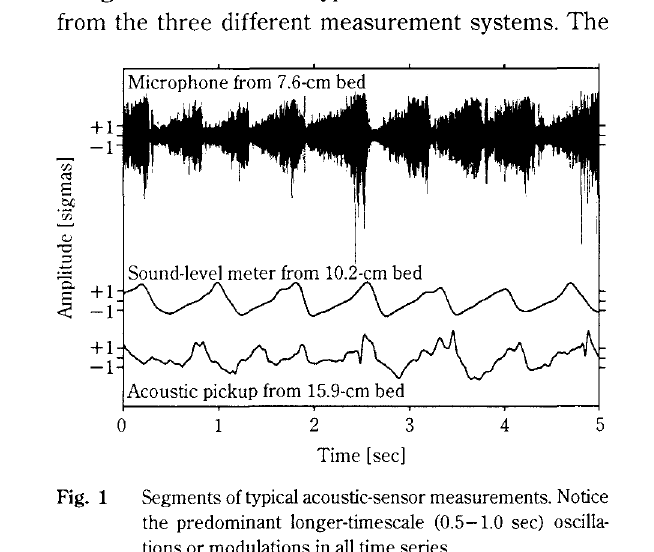
Segments of typical acoustic·sensor measurements. Notice the predominant longer-timescale (0.5-1.0 sec) oscilla· tions or modulations in all time